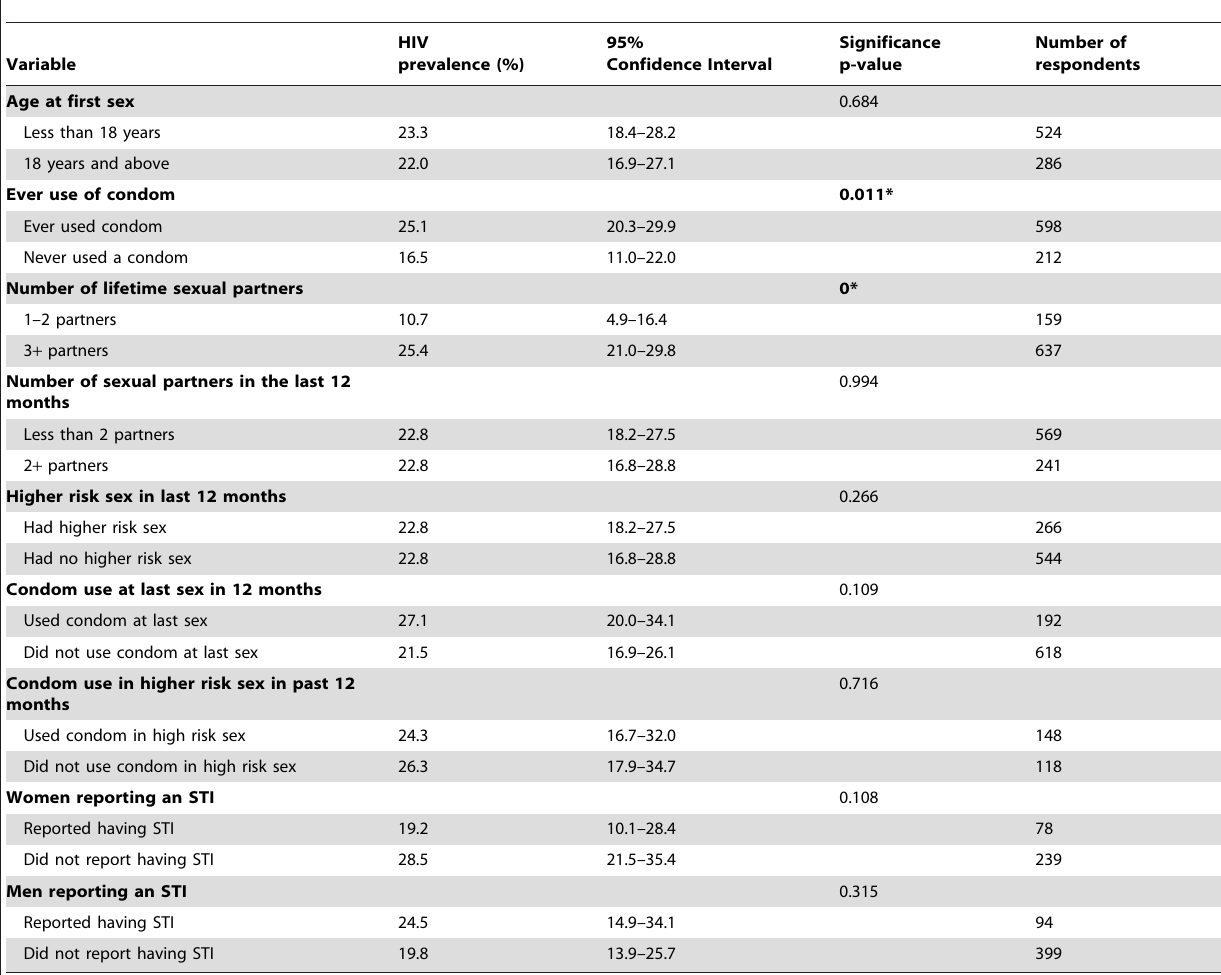
Table 4. Bivariate association with HIV sero-status among men and women age 15–49